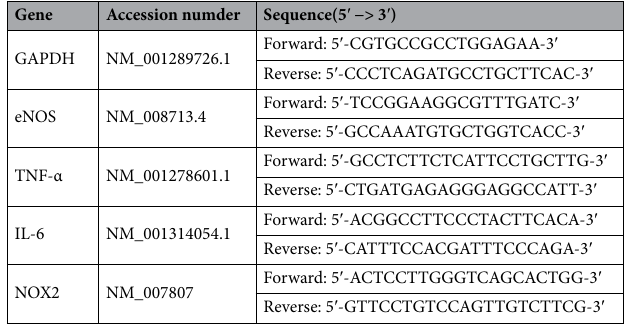
Table 1. Primers used in qPCR